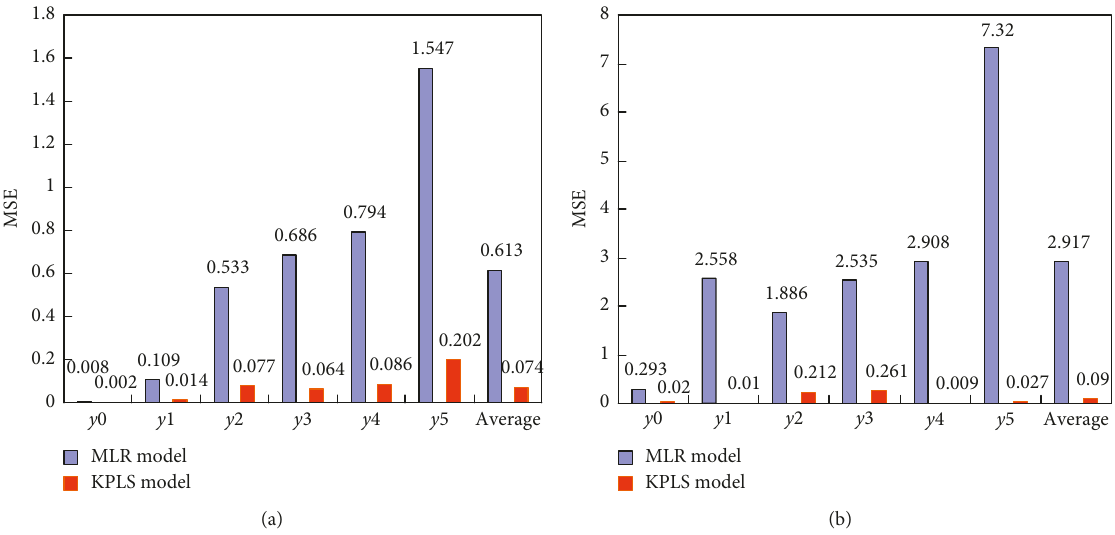
Figure 7: Fitting and forecast MSE of the MLR model and KPLS model. (a) Fitting. (b) Forecast.